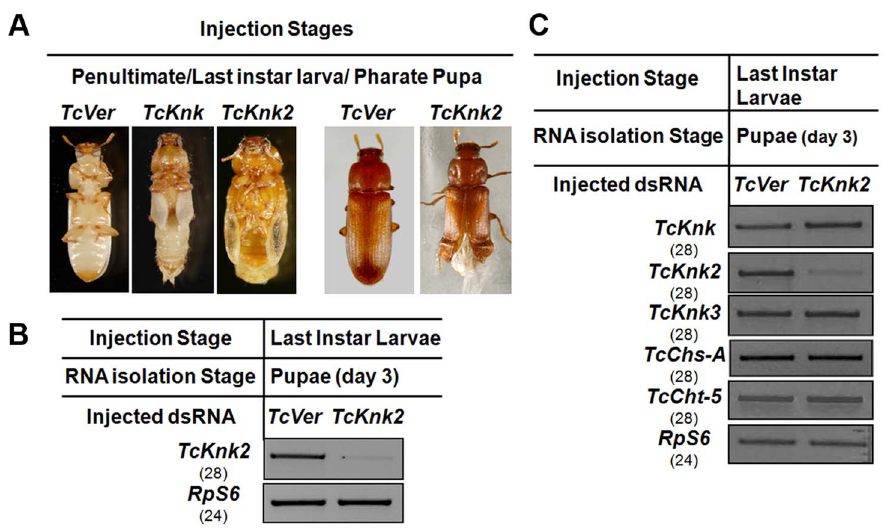
Figure 6. Effect of TcKnk2 dsRNA-treatment on the development of T.castaneum . (A) Injection of dsRNA for TcKnk2 into penultimate instar larvae, last instar larvae and pharate pupae (n=60) led to lethal phenotype at pupal-adult molt ( , 55%) and , 15% adult hypomorphic phenotype with split elytra. (B) Specific down-regulation of TcKnk2 transcripts by RNAi. dsRNAs (200 ng per insect) for TcKnk2 were injected into pharate pupae. Three days after injection, total RNA was extracted from whole insects of at pupal stage day 3 (n=3) and used for cDNA synthesis. (C) Specificity of TcKnk2 dsRNA-treatment. Effect of TcKnk2 dsRNA-treatment on transcripts for TcKnk , TcKnk3 and other genes involved in chitin metabolism such as TcChs-A and TcCht5 was checked by RT-PCR. T. castaneum ribosomal protein-S6 ( TcRPS6 ) was used as internal loading control. dsRNA for T. castaneum Vermilion ( TcVer ) and TcKnk was injected as a control.